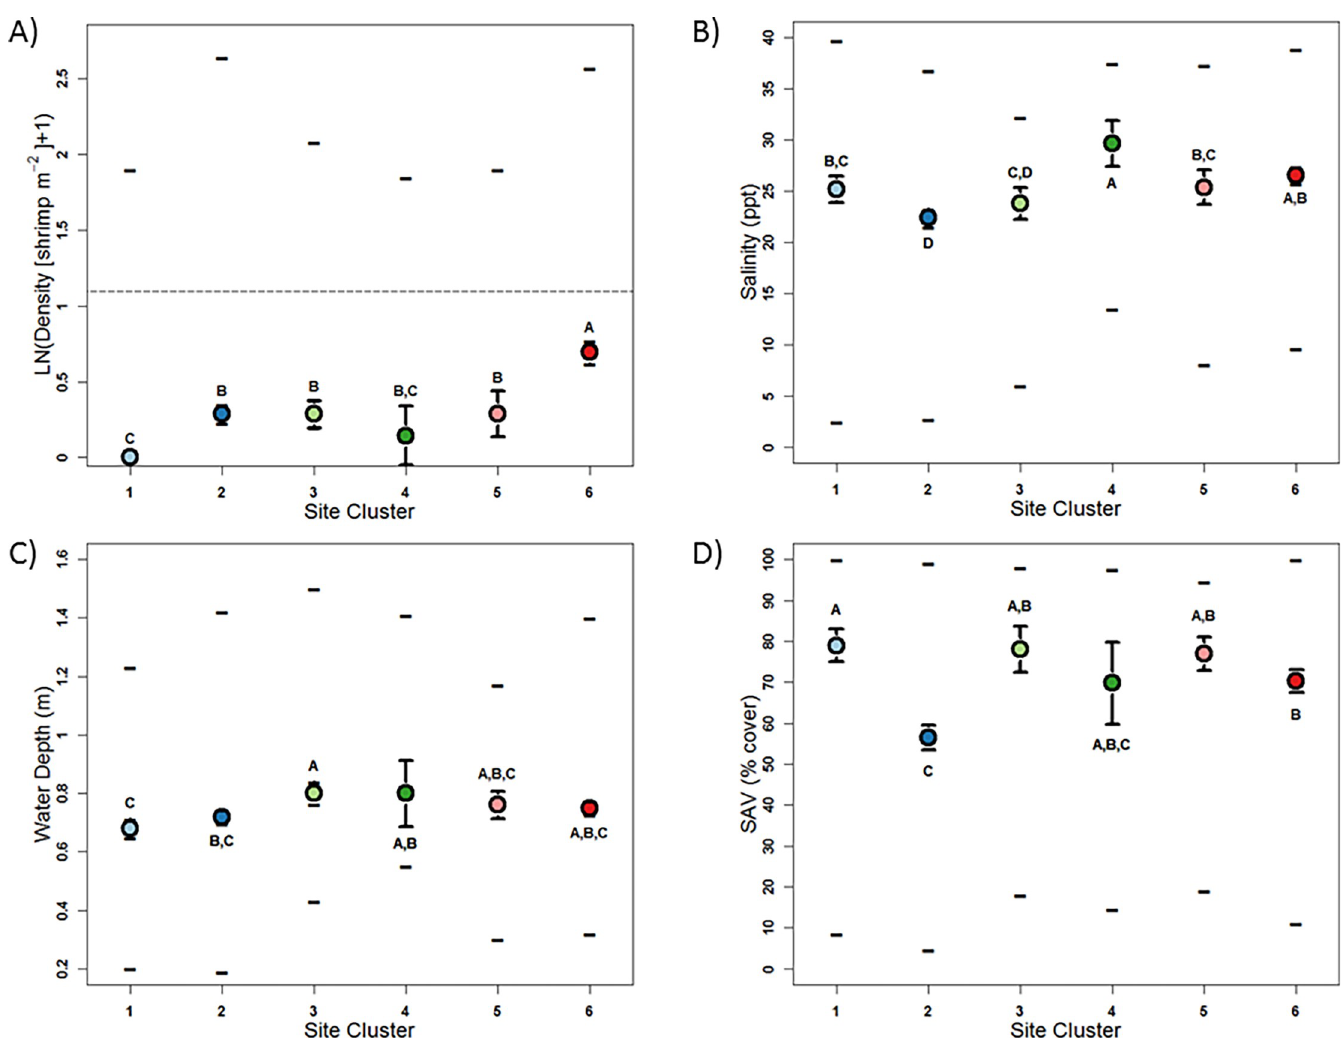
Fig 4. Median ( ± CI) and maximum, and minimum values of A) density (shrimp m -2 : LN([x+1]), B) salinity (ppt), C) water depth (m), and D) submerged aquatic vegetation (SAV: % cover) in shrimp density site clusters. Point colors coincide with Figs 1 and 3B. Letters denote statistically similar groups. Horizontal line of A) depicts the 2-shrimp m -2 CERP Interim